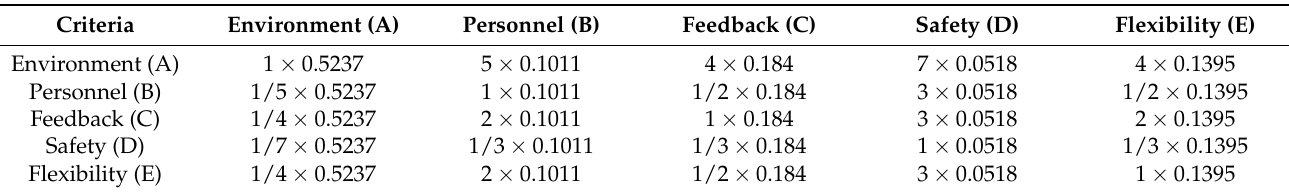
Table 7. Normalised matrix calculation.